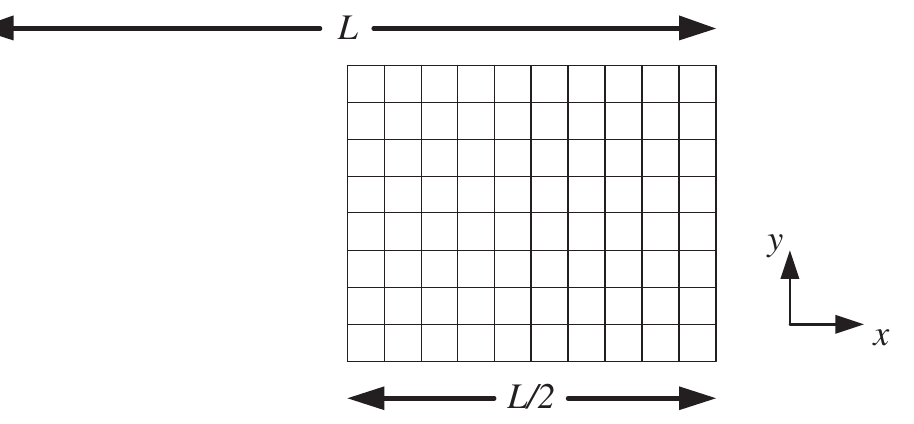
Figure A2. A simplified picture of the mesh when the surfce of the plunger is at x = L /2 and the mesh compression strategy is